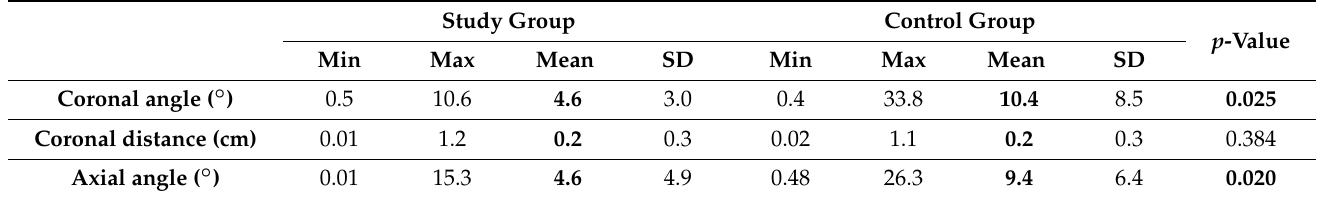
Table 2. The differences between the measurements pre-op and post-op in both groups.